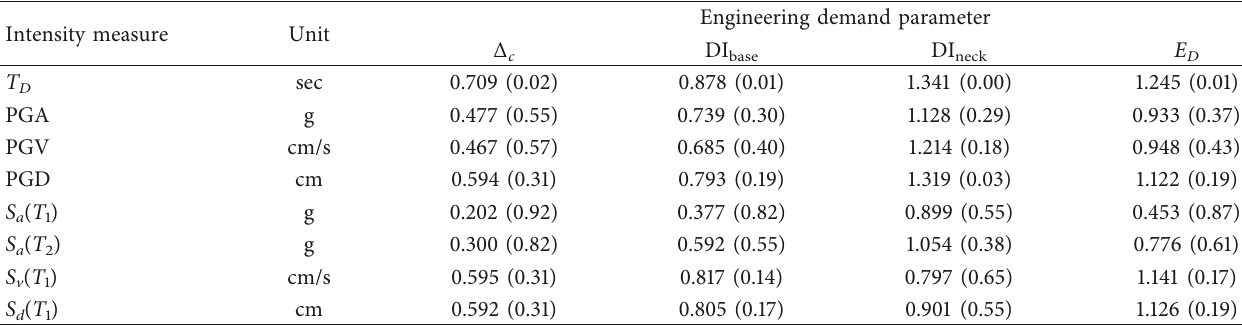
Figure 5: Illustrations of estimating the conditional mean value from linear regression of ln( Δ (b) IM � PGD. The normal distribution of the data points obtained from the mean and standard deviation of the regression is also Table 2: Dispersion of EDP | IM considering single-valued IMs. The numbers in parentheses are the R 2 values of the corresponding linear regressions. Intensity measure